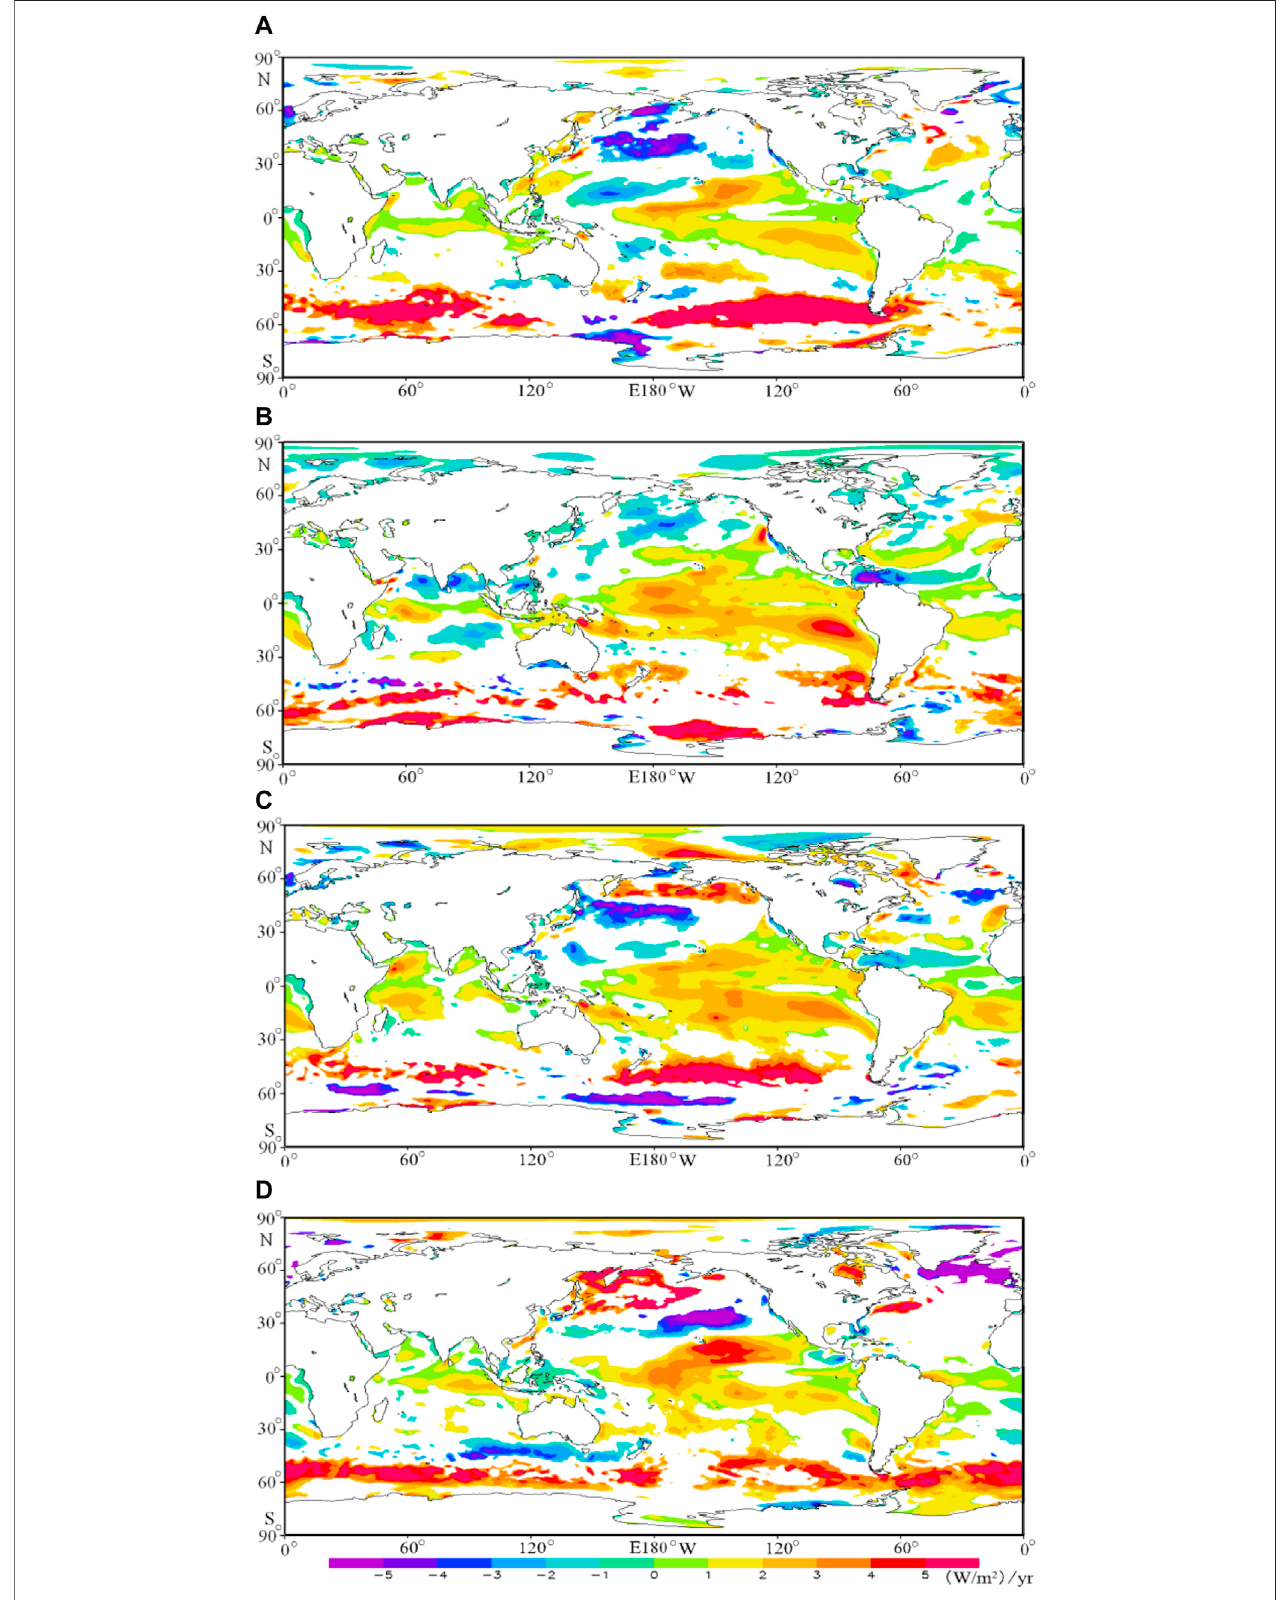
FIGURE 6 | Long-term trends of the wind power density in MAM (A) , JJA (B) , SON (C) , and DJF (D) in the global ocean. Only area signi fi cant at 95% level is presented.